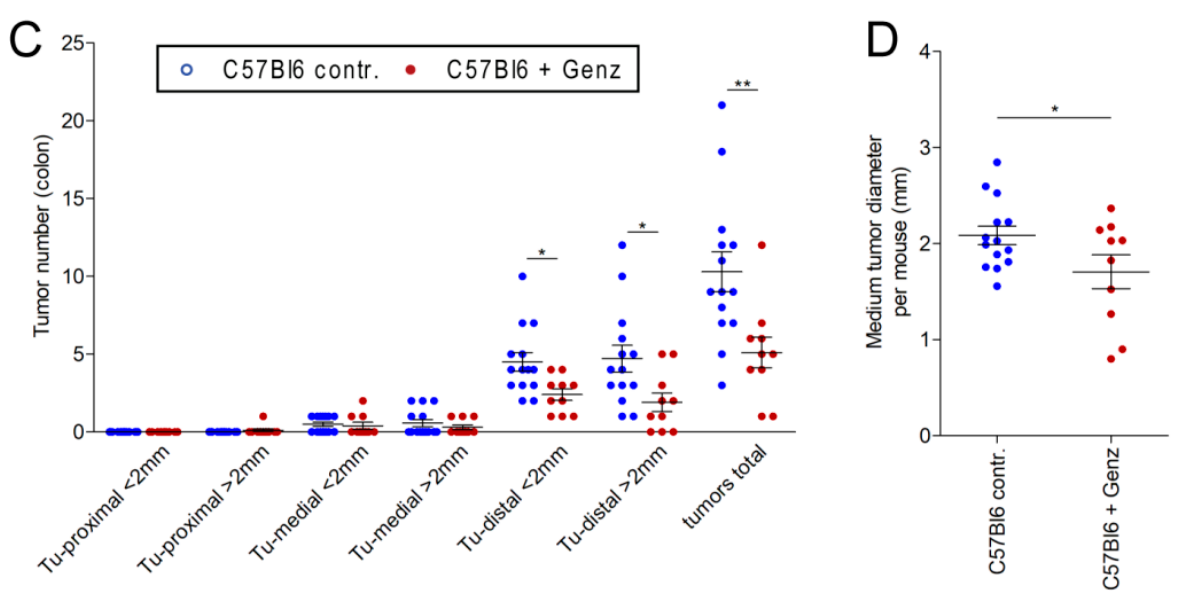
Figure 7. Genz treatment lowered the incidence of experimental CRC in vivo. ( A ) Scheme of the treatment course. CRC was induced in C57Bl6 mice with azoxymethane (AOM) at the age of 8 weeks, followed by a tumor promoting 5-day cycle of dextrane sulfate (DSS) applied by the drinking water starting one week after the AOM-treatment. Mice, n = 24, received chow diet until five weeks after tumor induction. Then one cohort of animals, n = 10, received 0.225% Genz in the food. All animals were sacrificed 15 weeks after tumor induction according to the termination criteria from the animal application. ( B ) Scheme of the human and murine intestinal tract. Colorectal tumors in humans develop preferentially in the areas of the sigmoid colon and the rectum but also in other areas of the large intestine. In this mouse model, we observed tumors predominantly restricted to the rectal area of the colon with a critical load at fifteen weeks after tumor induction. ( C ) Treatment of mice with Genz resulted in a markedly lower number of colorectal tumors in the distal part of the colon. ( D ) The size of tumors detected in the colons of Genz-treated mice was also notably smaller as compared to chow fed mice; each data point represents the mean size of all tumors detected in one mouse; significances are *, p ≤ 0.05; **, p < 0.01.